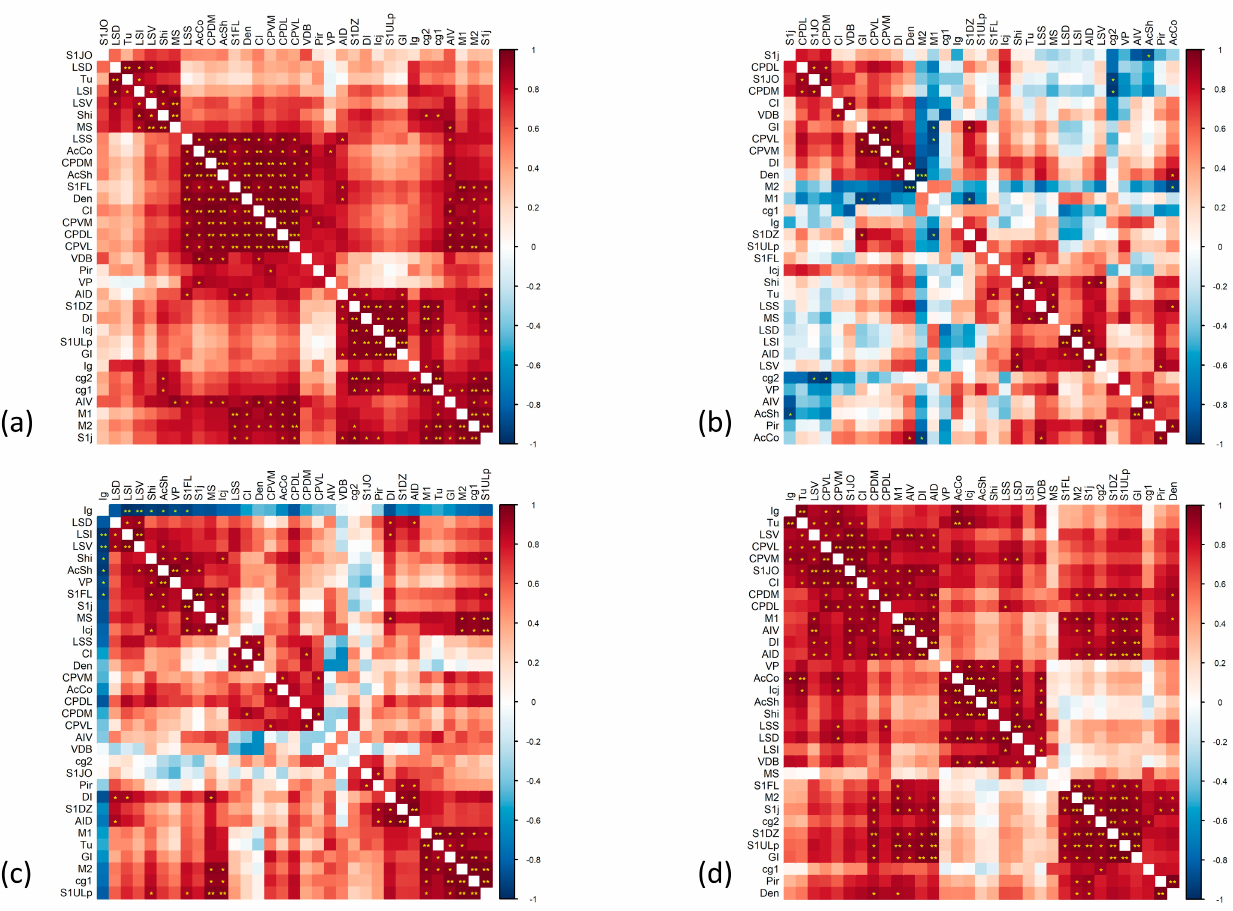
Figure 2. Correlation matrix for VEH/VEH ( a ), VEH/ASE ( b ), KET/VEH ( c ), and KET/ASE ( d ) group. Variables are grouped according to hierarchical clustering. According to the color scale on the right of the matrix, positive correlations are reported in red, negative ones in blue. Asterisks represent significance levels, accordingly: p -values < 0.05 are indicated with an asterisk, p -values < 0.01 with two asterisks, p -values < 0.001 with three asterisks. VEH: vehicle; KET: ketamine; ASE: asenapine.